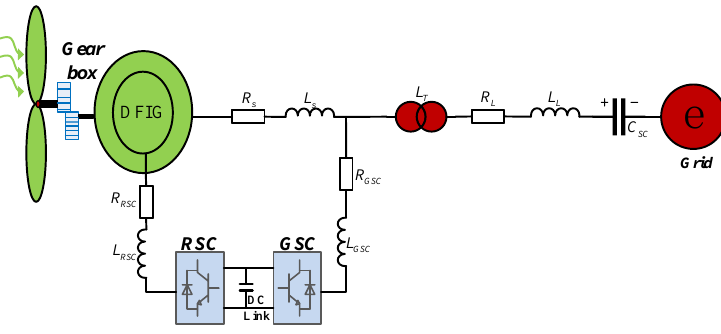
Figure 1. Series-compensated DFIG-based wind farm grid-connected system.